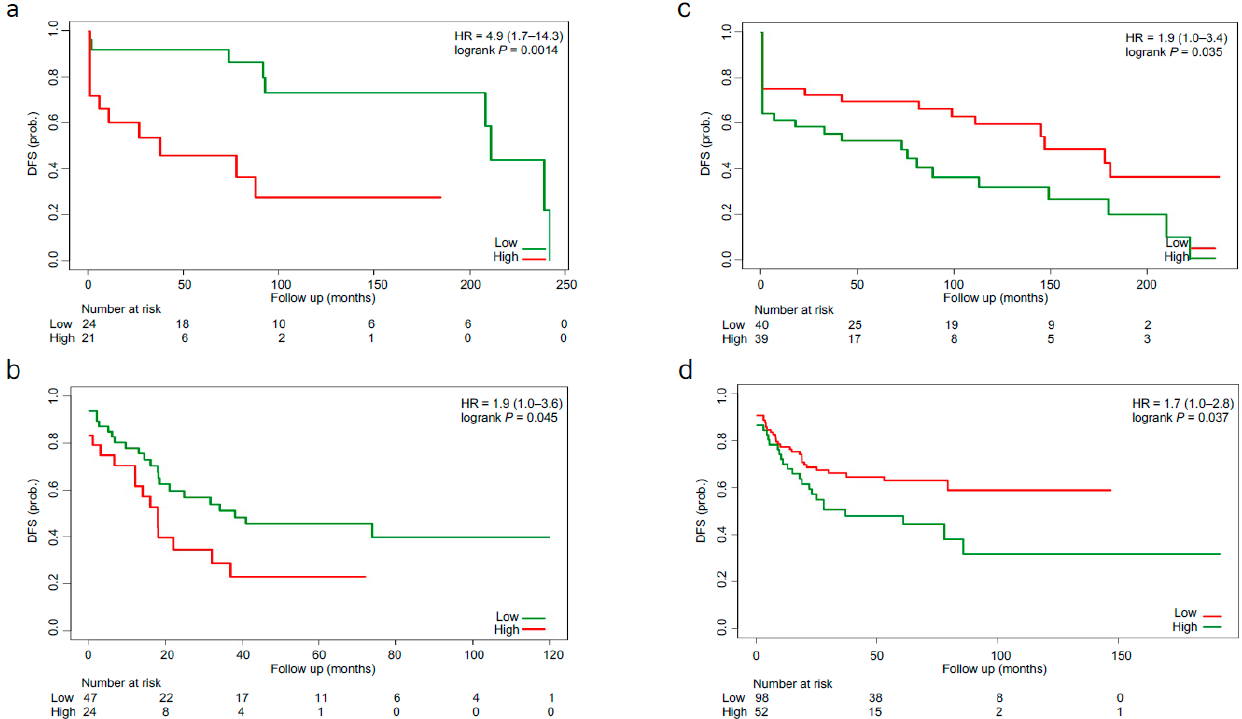
Figure 6. Two Cox models built by using the TME-associated fibroblast and cDC. A Cox model built by using tumor- infiltrating fibroblast in the TCGA SSCS4 patients ( n = 45), which can be used to classify the SSCS4 patients both from the TCGA ( a ) and GEO ( b ) cohorts into high- and low-risk groups. Another Cox model built by using the TME-associated cDC in the TCGA SSCS3 patients ( n = 79), which can be used to classify the SSCS3 patients both from the TCGA ( c ) and GEO ( d ) cohorts into high- and low-risk groups.